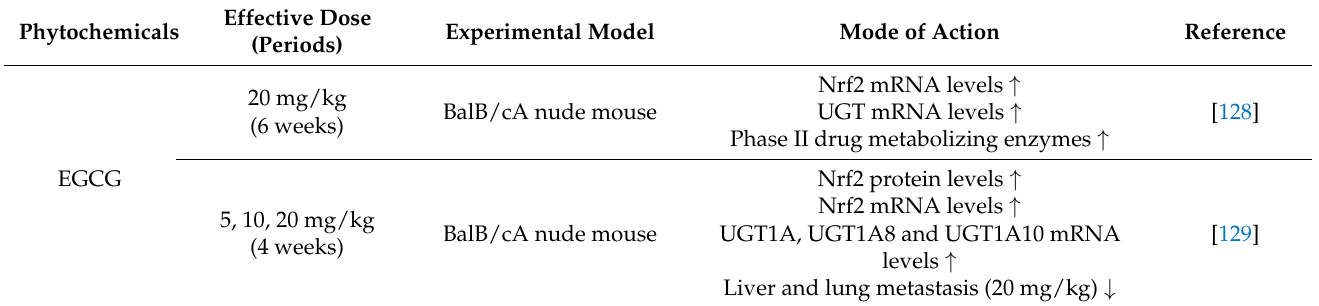
Table 2. List of phytochemicals targeting Nrf2/KEAP1 for colorectal cancer.